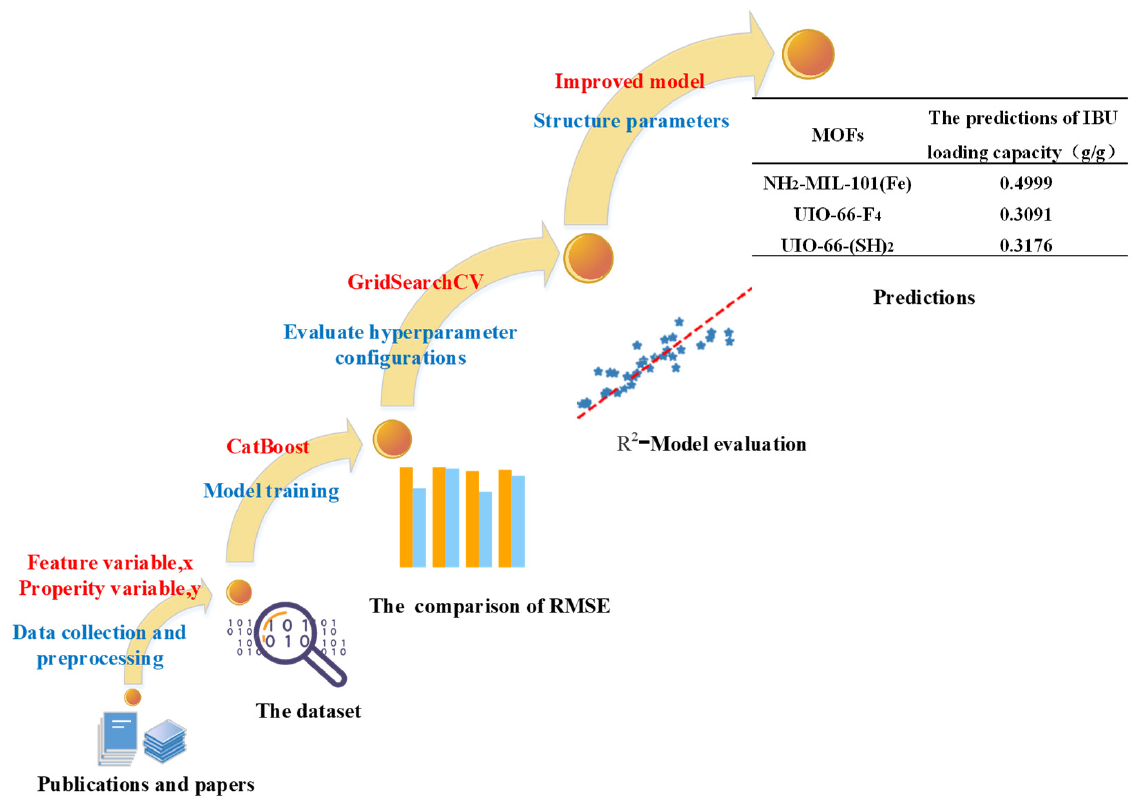
Figure 2. The flow chart of the research approach for the prediction of the IBU loading capacity of MOFs.